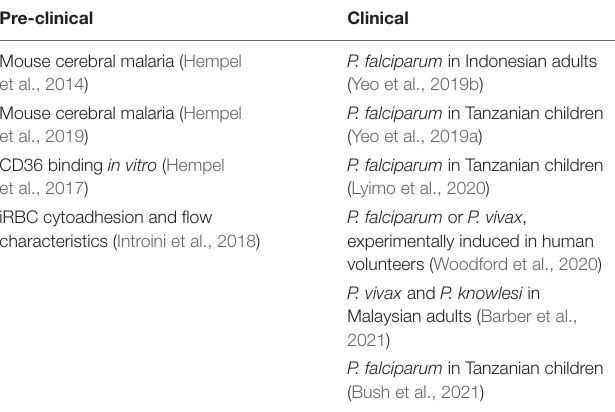
TABLE 1 | Studies of eGC in